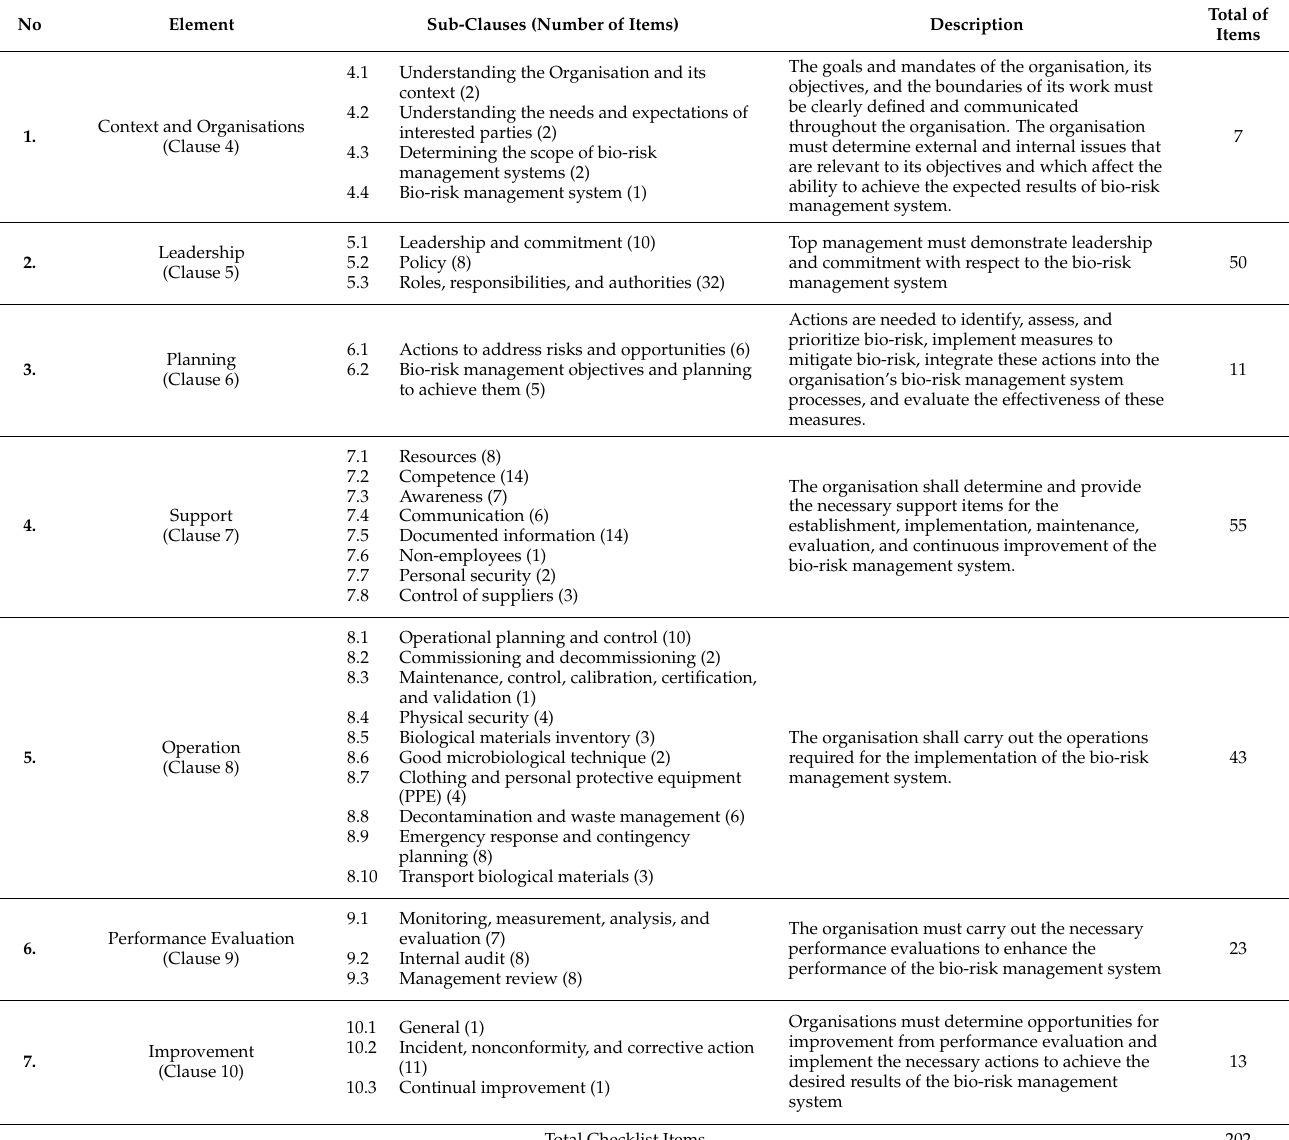
Table 2. International Standard Organisation (ISO) 35001:2019 elements and checklist